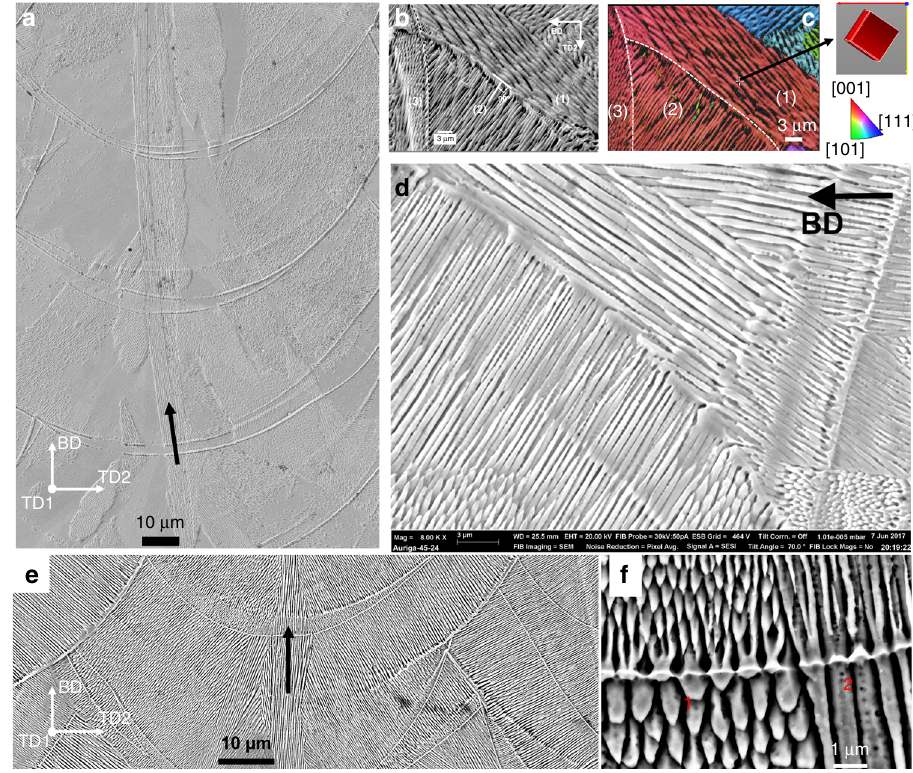
Fig. 4 The microstructure developments due to continuous growth and side-branching in AM 316L. a Continuous growth of cells in a slender domain (highlighted by a black arrow) along the centreline across melt pools in the bi-directional scan without rotation. b – d Side-branching frequently occurred at sides of melt pools observed in all scan strategies. b Cells in (3) epitaxially grew from ones in (2) which did grow from cells in (1), and c is a coresponding inverse pole fi gure along TD1 of region in a . d Side-branching of cells occurred at a fusion boundary. e Continuous growth and f sidebranching (region 1) and tip-splitting (regions 1 and 2). Note: 316L steel was fabriccated by a – d the modulated laser beam (Renishaw) and e – f continuous wave laser beam (Concept Laser); the dashed lines in b and c represent the melt-pool boundary; b and c were reused with permission provided by AIP Publishing.